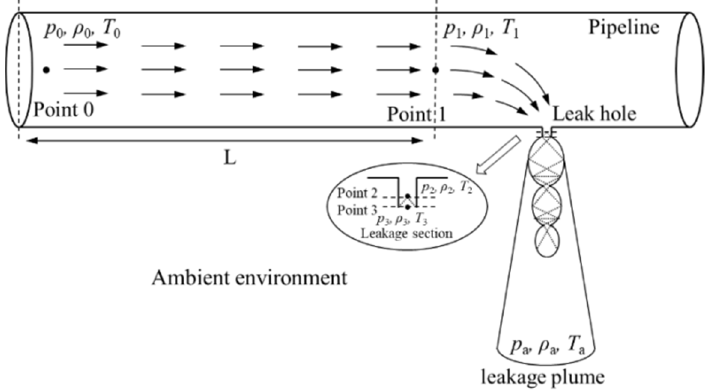
Figure 2. Schematic diagram of the gas leakage process in the improved model.